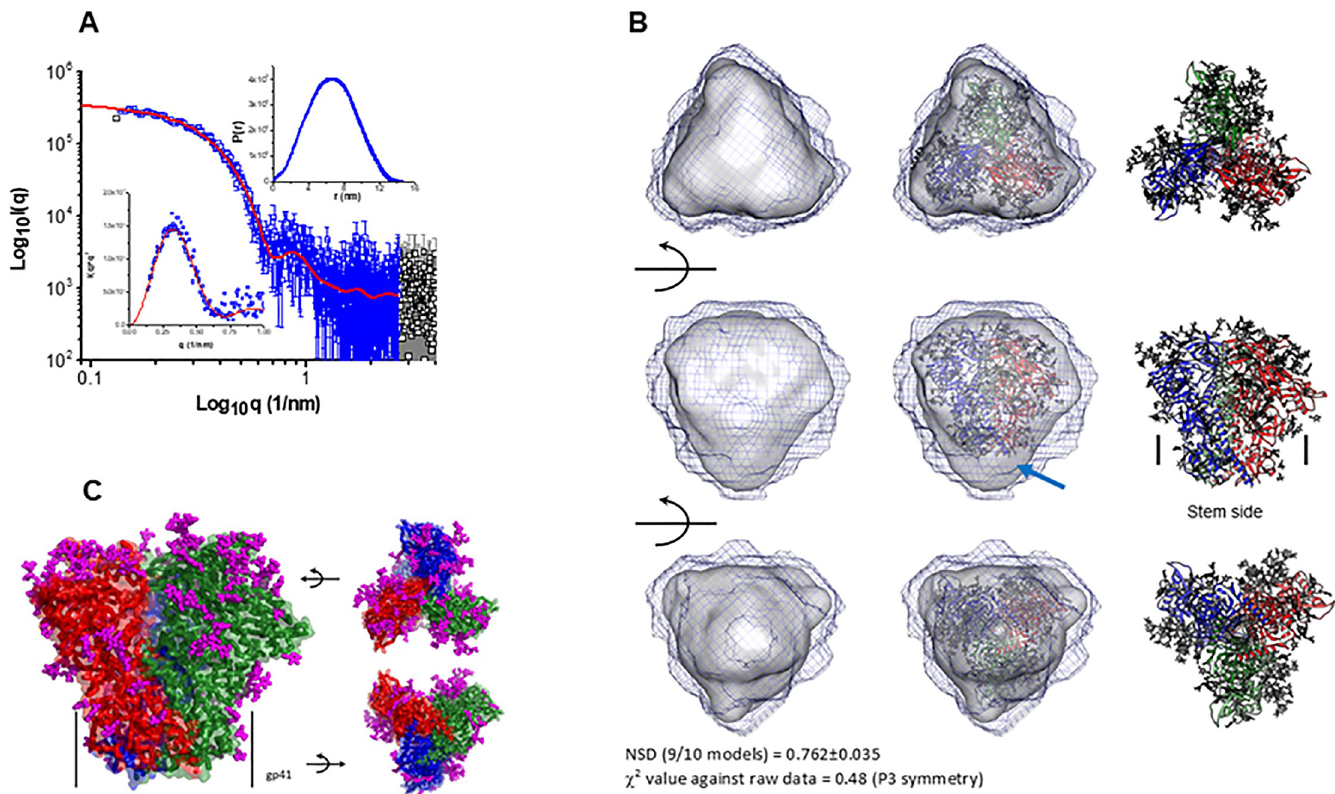
Fig 5. Examining trimeric conformation of 1PGE-THIVC by small angle X-ray scattering (SAXS). A. SAXS profile of the 1PGE-THIVC SOSIP at 1 mg/ml is presented in double log mode (black symbols). The blue symbols indicate the q range used to model the P(r) curve for this protein (shown as upper inset), and the red line represents the estimated SAXS profile from the P(r) curve. Lower inset shows the Kratky plot of data (blue symbols) and modelled profile (red line). B. (Left column) Three rotated views of the solution shape of 1PGE-THIVC SOSIP protein restored within shape constraints present in SAXS data are shown here. Average of ten models is shown as grey map and variation in the models is shown as black mesh map. (Middle column) Automated superimposition of the residue level model of 1PGE-THIVC SOSIP generated using primary structure of same protein and model structure of PDB ID: 6B0N with sugar moieties, and the SAXS based model have been shown. The residue level model is shown in ribbon format with three chains are shown in blue, green and red, and sugar moieties have been shown as sticks. (Right column) The residue level models superimposed in central column are shown independently. Middle panel shows where the stem side or gp41 portion is present in the model. The red arrow highlights gap in the SAXS based model vs. residue level model near the stem or gp41 region possibly due to accessible flexibility in solution. Normalized spatial disposition (NSD) amongst ten models solved using SAXS data and χ 2 value between final averaged model vs. raw data are mentioned in bottom. C. Modeled structure of 1PGE-THIVC SOSIP trimer using primary structure, SAXS data-based information and template of PDB ID: 6B0N is shown here. Three chains of gp120 are shown in red, green and blue colors. The C α traces are shown as ribbons, and surfaces are shown in transparent mode. The sugar moieties representing glycosylation are shown as magenta sticks. The black arrows aid in providing the rotations done in model to present the